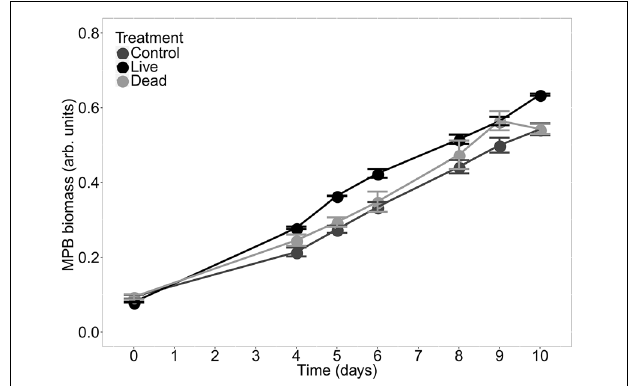
FIGURE 3 | MPB biomass (mean ± SE, n = 3) as a function of time measured at the surface in the inner bed sediment for the three treatments.